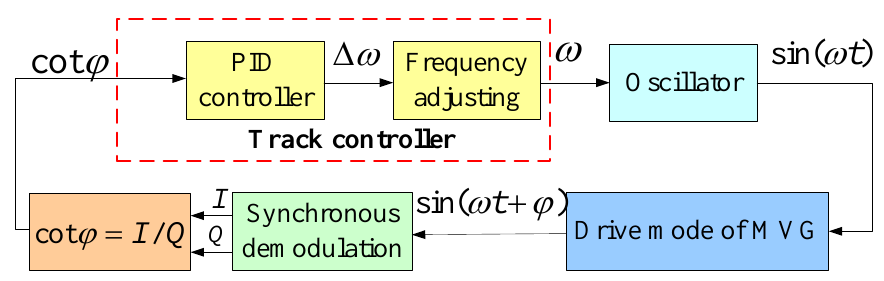
Figure 6. The block diagram of the track method.